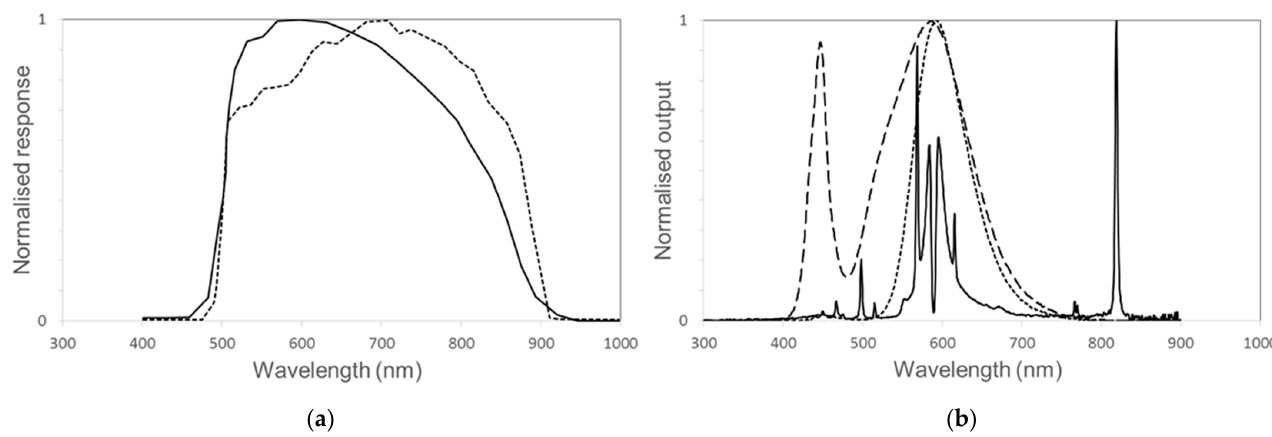
Figure 1. Typical normalized spectral response of satellite sensors and selected streetlighting types. ( a ) the DMSP-OLS (solid line) and VIIRS-DNB (dashed line) sensors, compared with ( b ) normalized output of high pressure sodium (solid line), 1800 K LED (short dashes) and 4000 K LED (long dashes) streetlights.